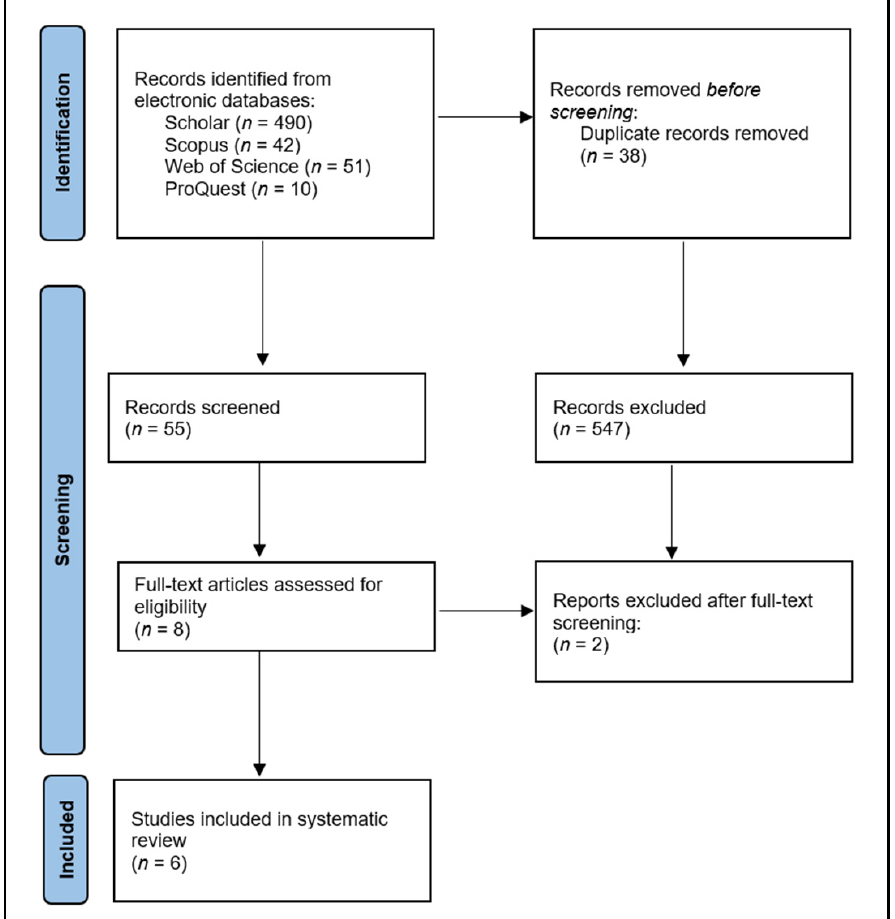
Figure 1. PRISMA Flow Diagram.